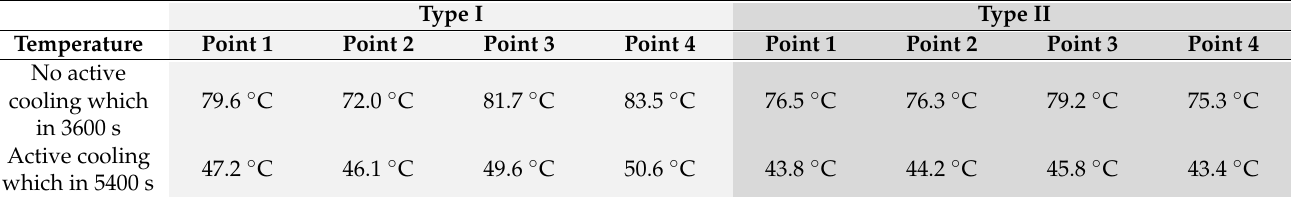
Table 4. The comparison of upper-plate